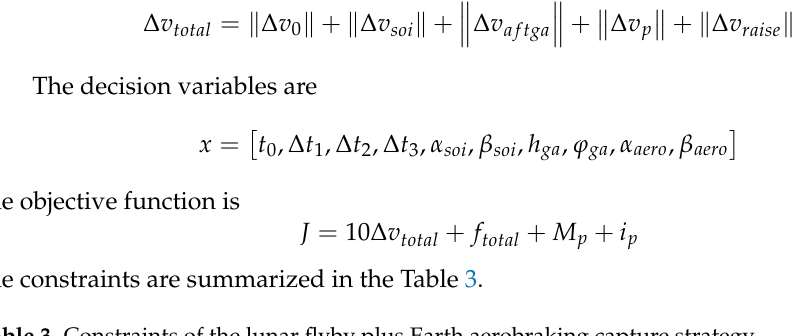
Table 3. Constraints of the lunar flyby plus Earth aerobraking capture